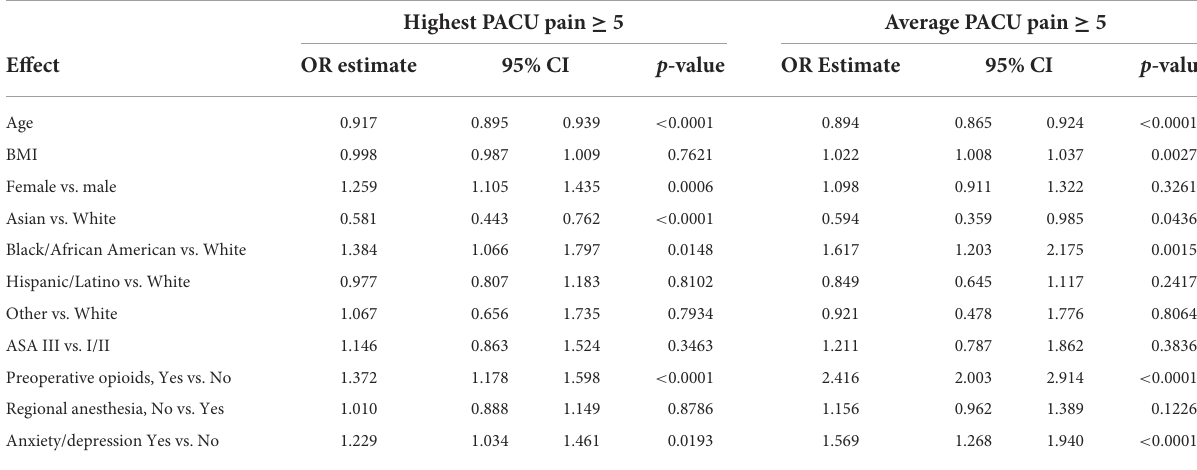
TABLE 5 Multivariable analysis of the association between highest and average PACU pain scores and the perioperative characteristics of 4,791 adults undergoing open abdominal